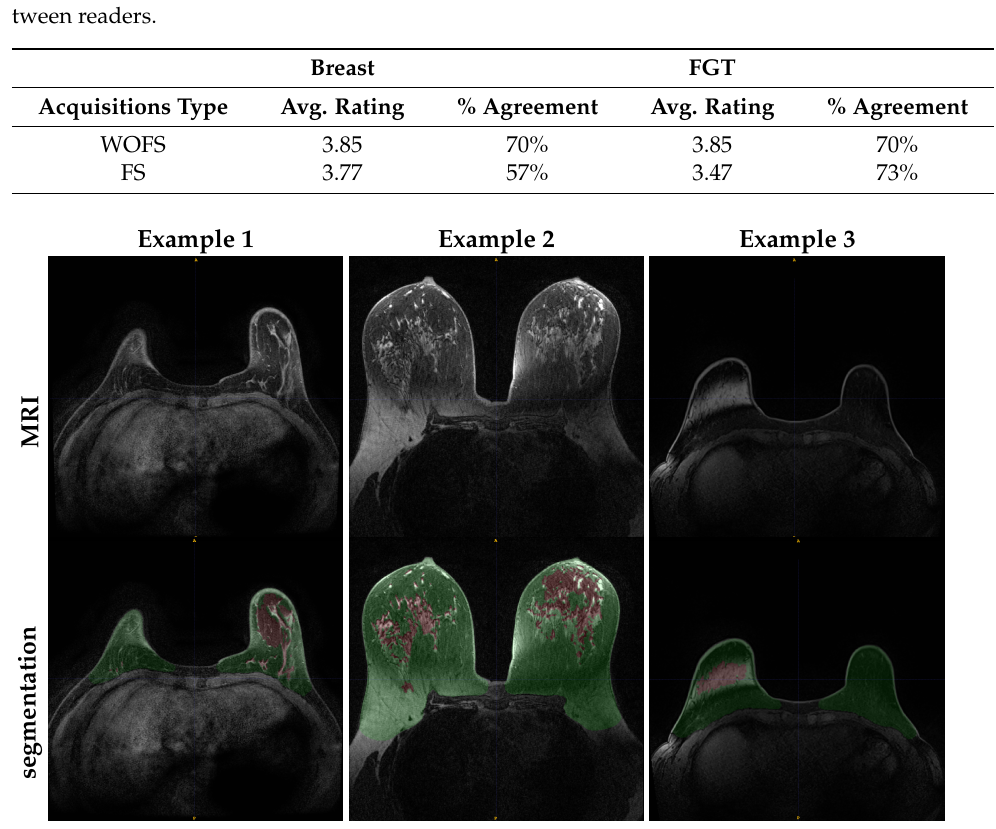
Table 7. External test set results (n = 30 patients, 60 acquisitions (30 WOFS, 30 FS)). Reader study